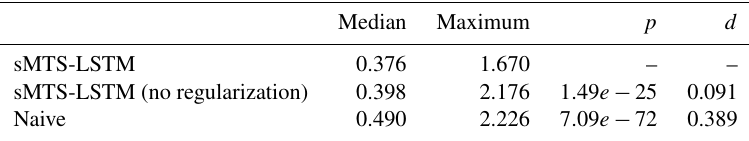
Table 5. Median and maximum root mean squared deviation (mmd − 1 ) between daily and day-aggregated hourly predictions for the sMTS- LSTM with and without regularization, compared with independent prediction through naive LSTMs. p and d denote the significance (Wilcoxon signed-rank test) and effect size (Cohen’s d ) of the difference to the inconsistencies of the regularized